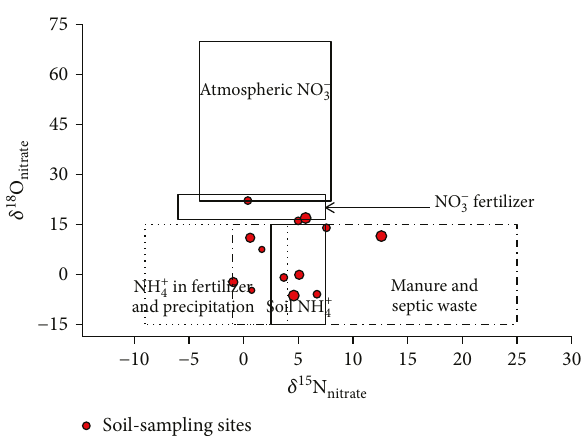
Figure 6: Dual-isotope method for nitrate source attribution in soil, September 2012. Modi fi ed from Fenech et al.